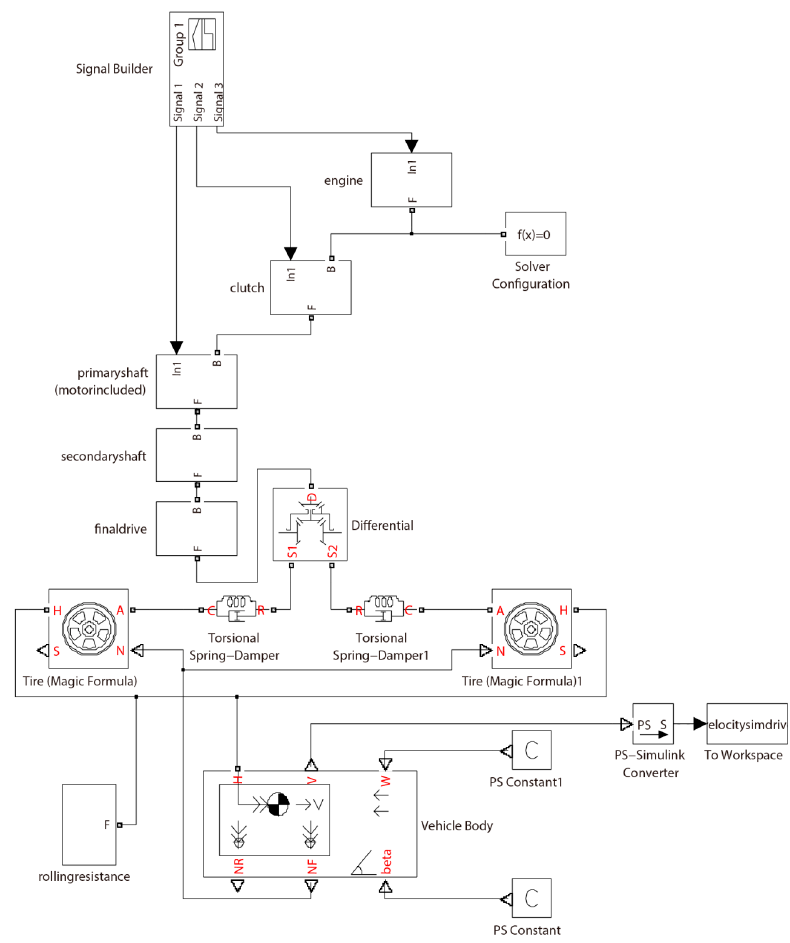
Figure 4. Matlab SimDriveline model of the CPPHP.